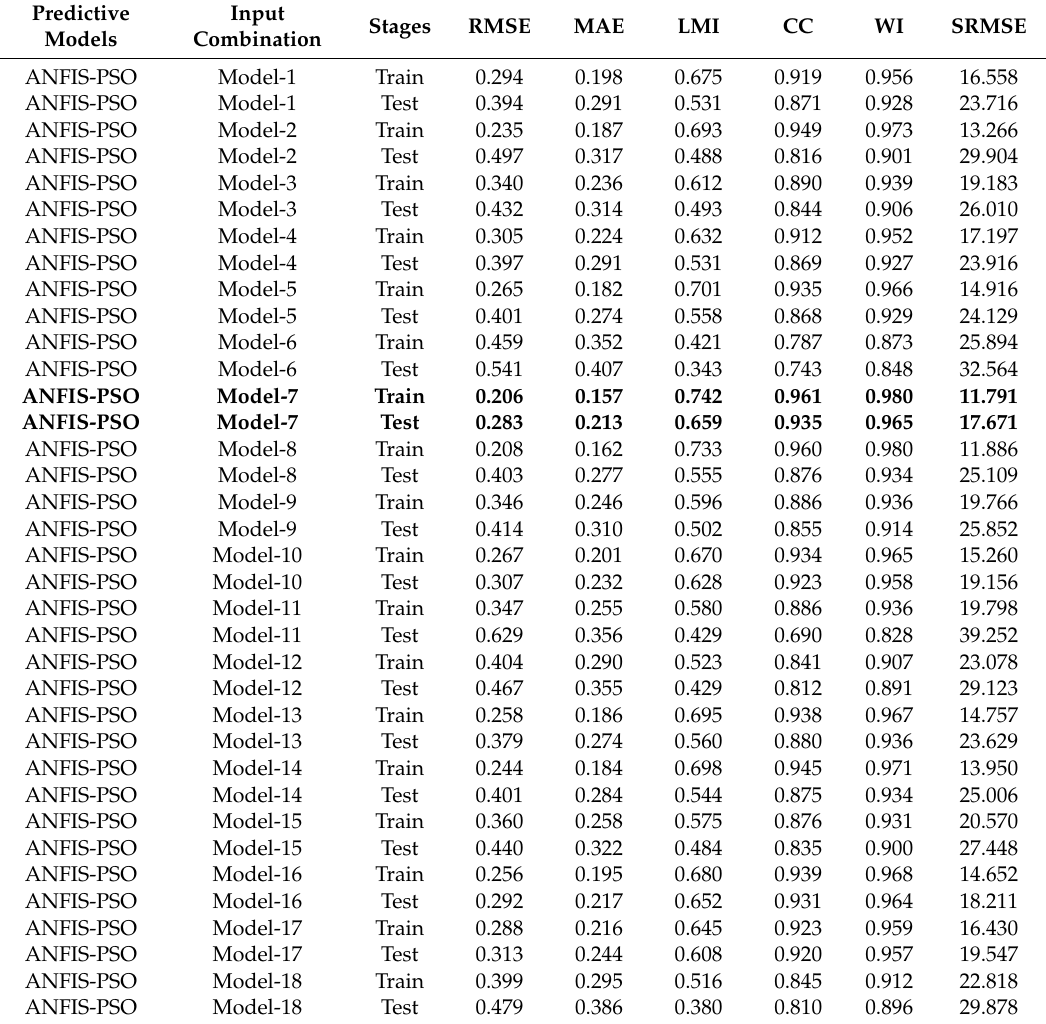
Table 6. The prediction performance of the hybrid ANFIS-PSO model for all proposed input combinations over the training and testing stage. The boldface denotes the best modeling